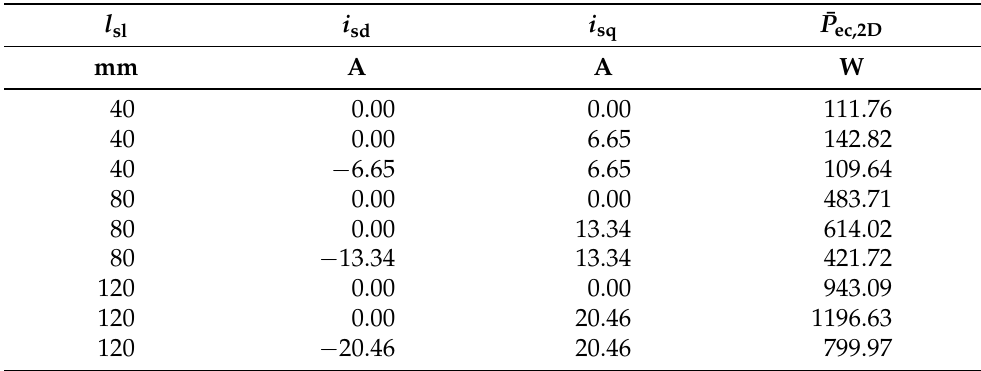
Table 3. Simulation results of ¯ P ec,2D at